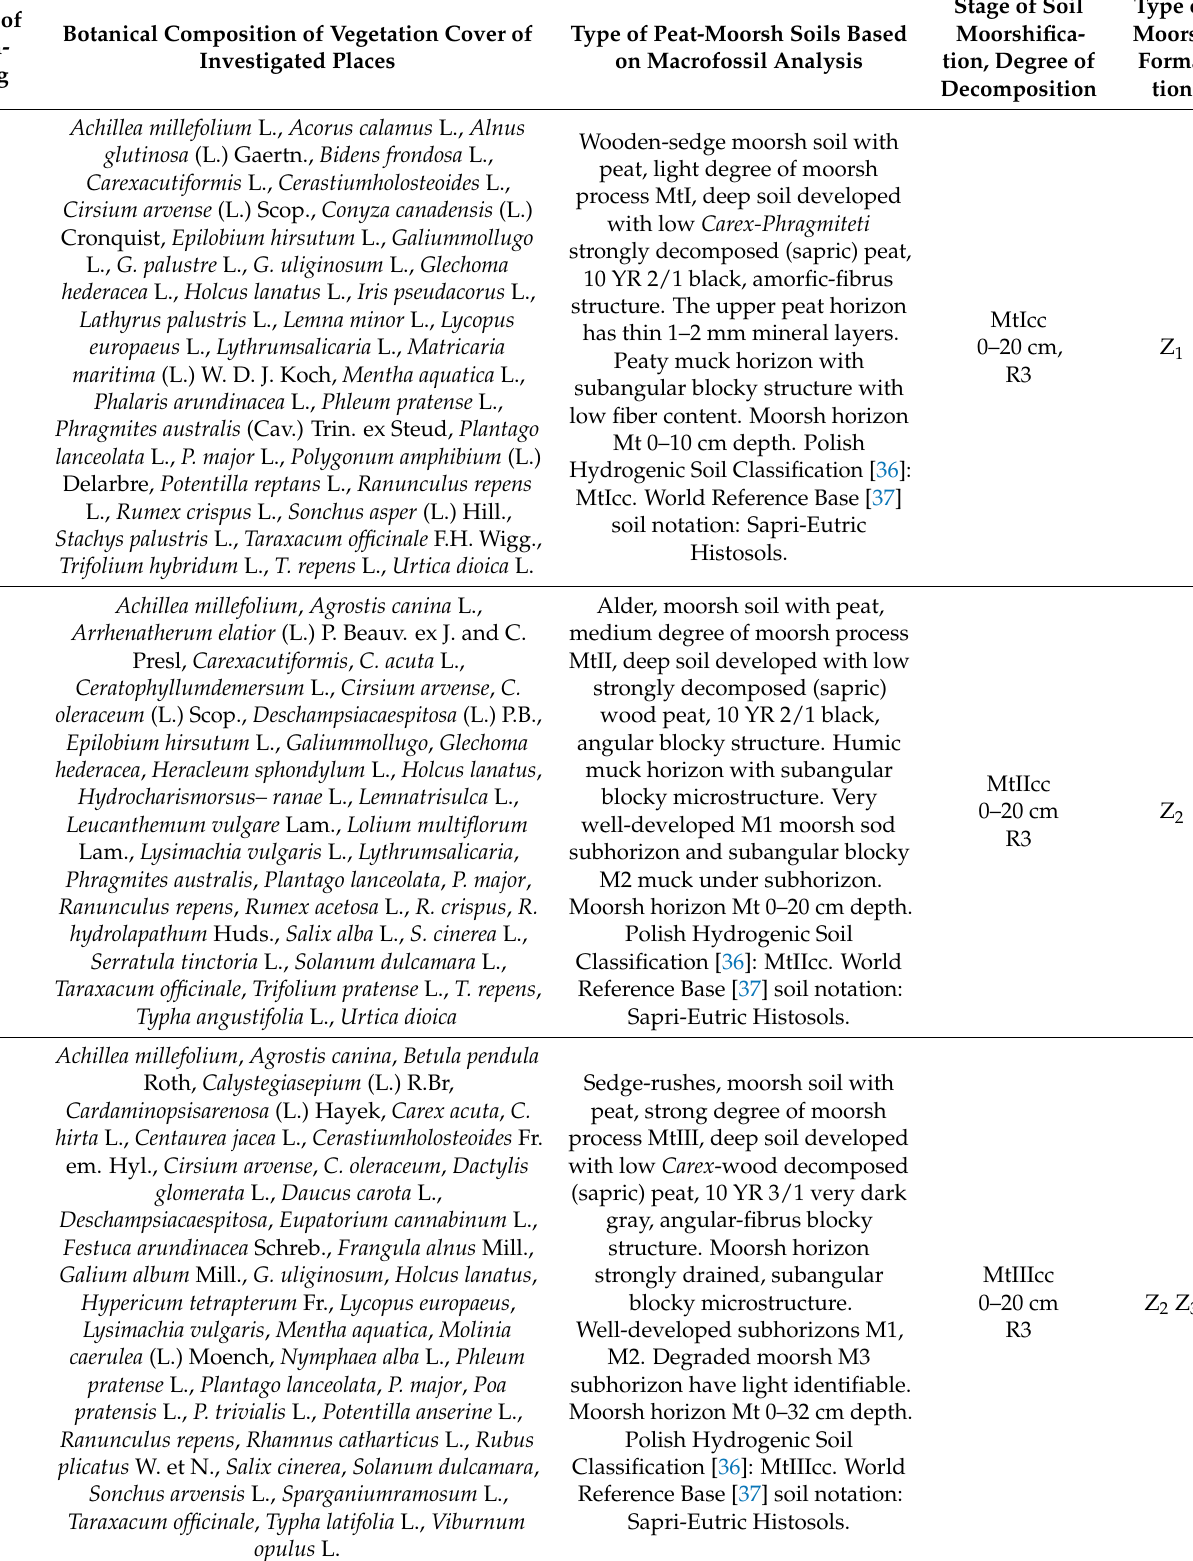
Table 2. Plants associations of investigated peatland and some properties of peat-moorsh soils. Investigated Places